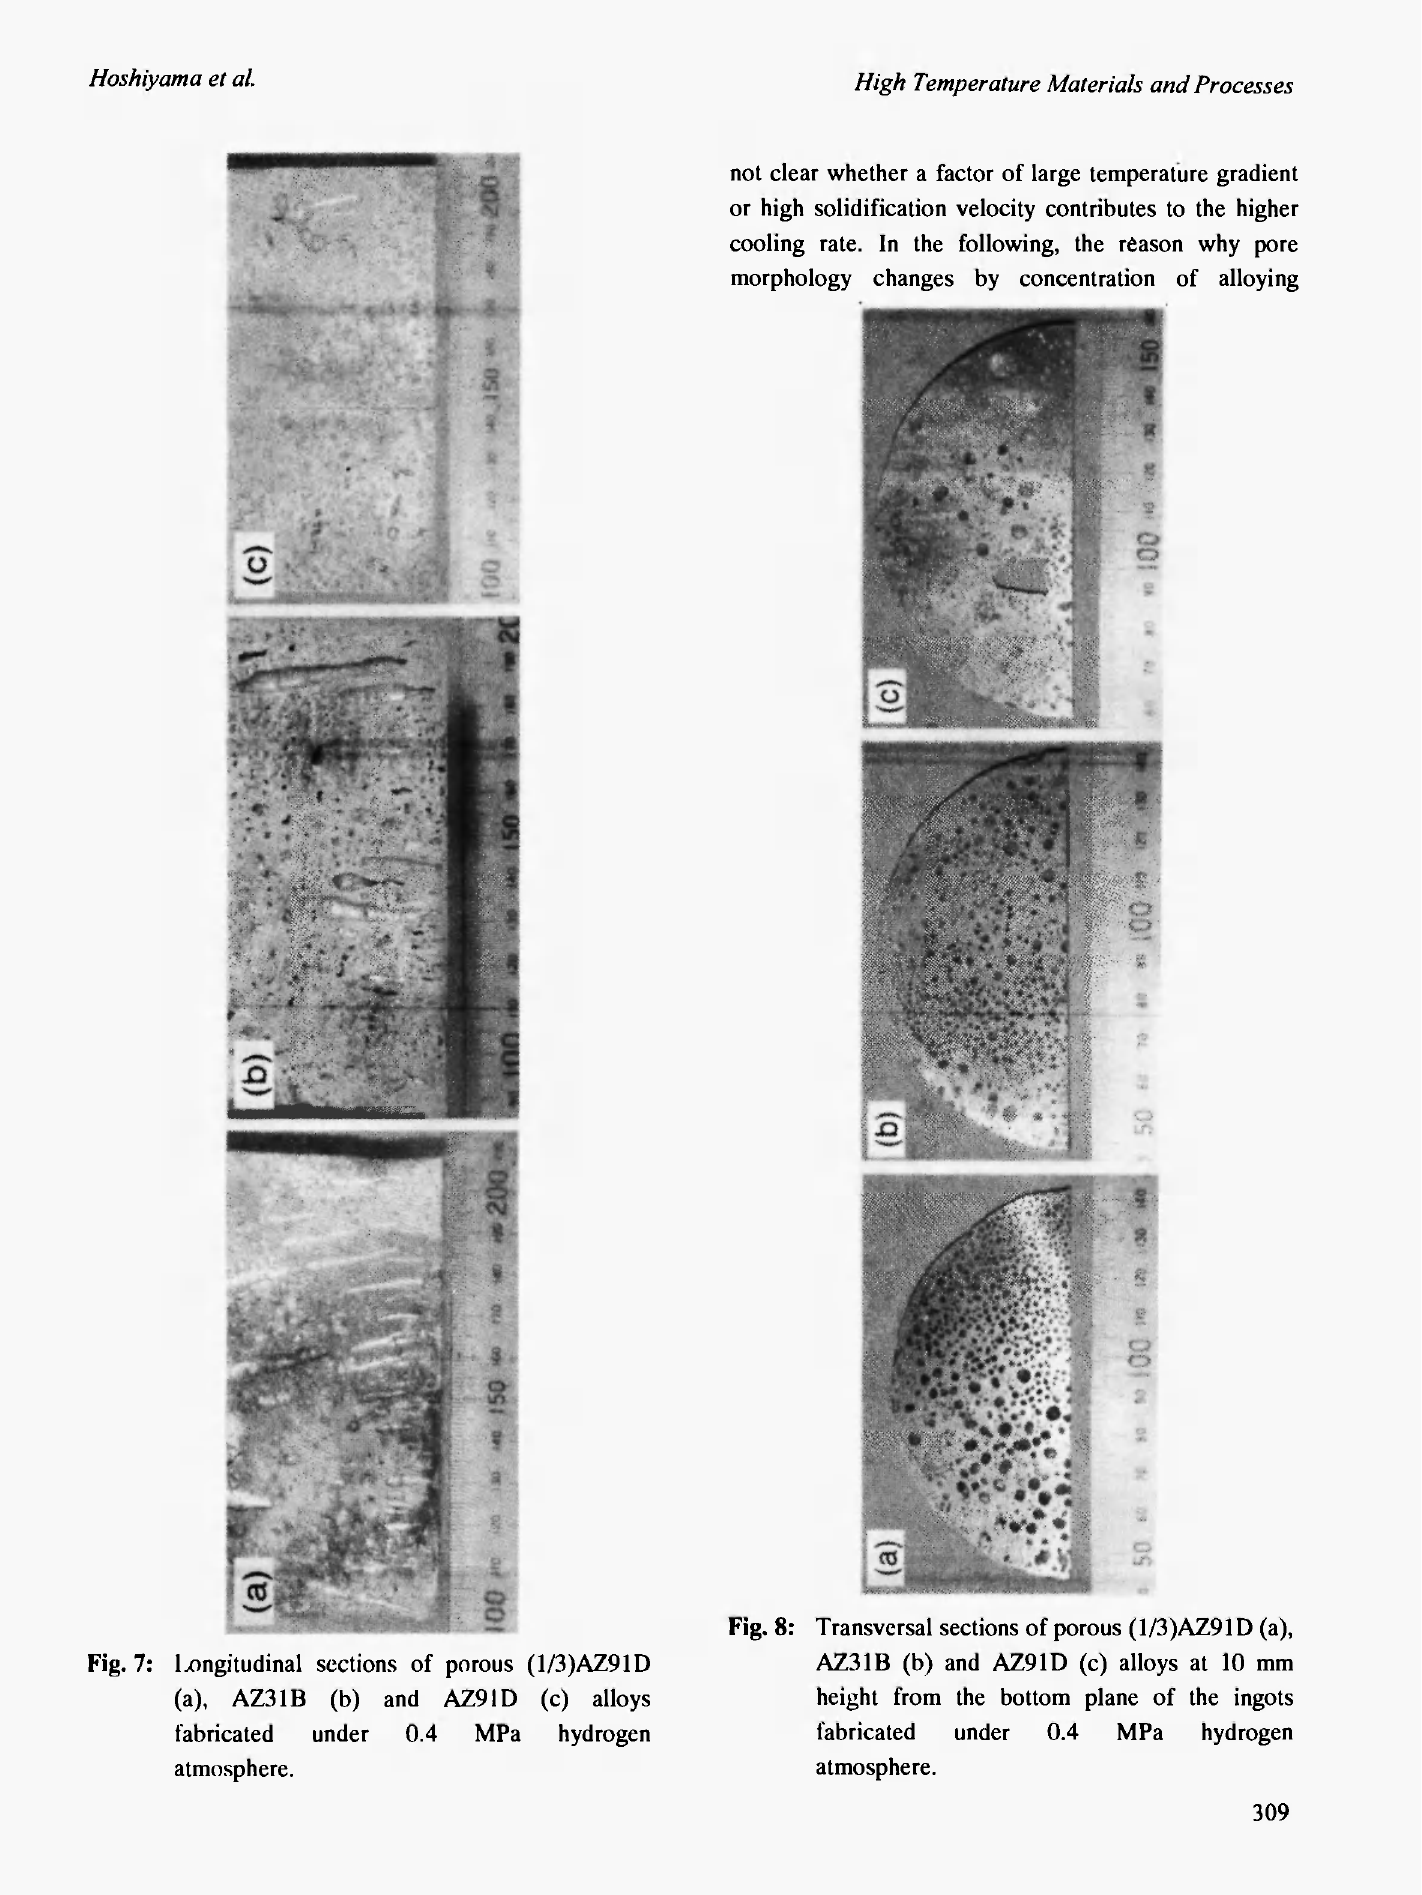
Fig. 8: Transversal sections of porous (1/3)AZ91D (a), AZ31B (b) and AZ91D (c) alloys at 10 mm height from the bottom plane of the